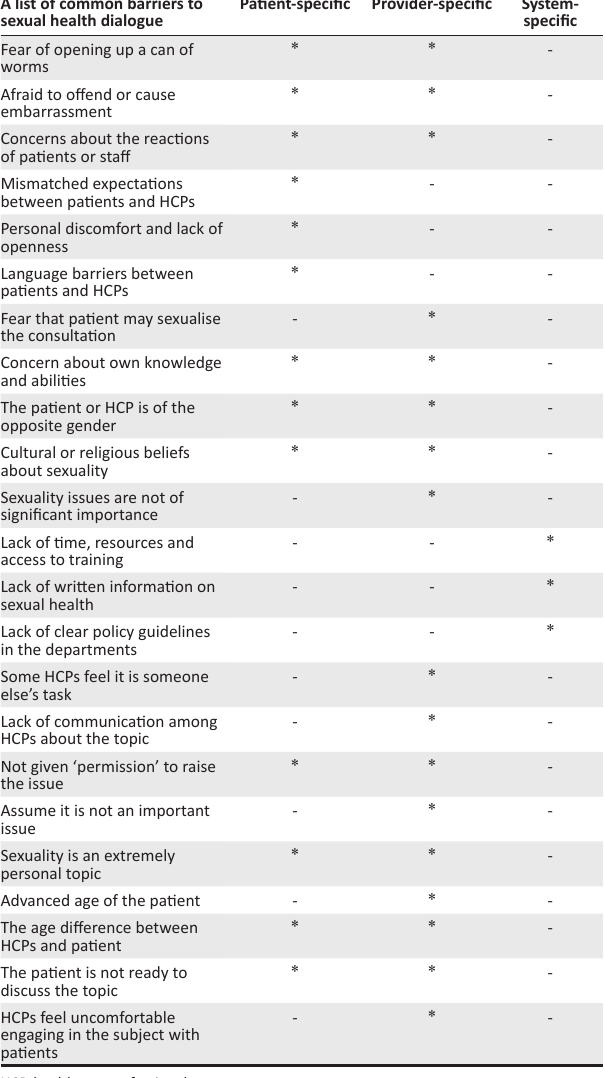
TABLE 3: Barriers to sexual health communication in clinical